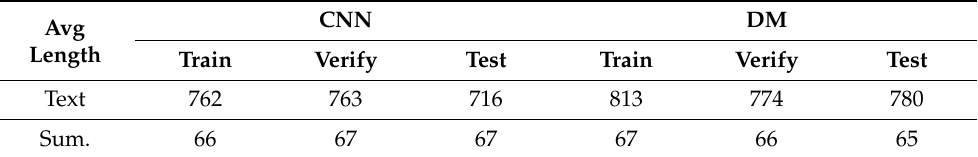
Table 1. Length statistics of